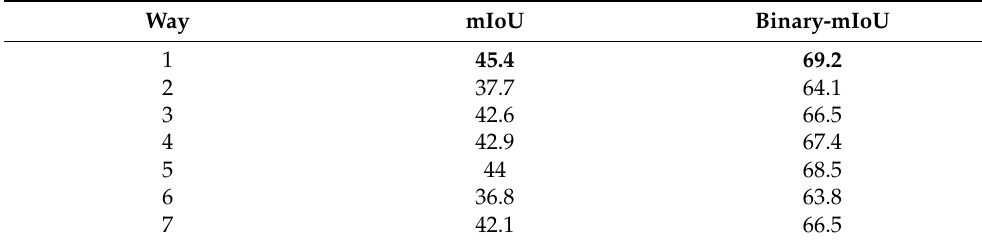
Table 5. Multiple prototypes and multiple query feature maps to establish relationships.